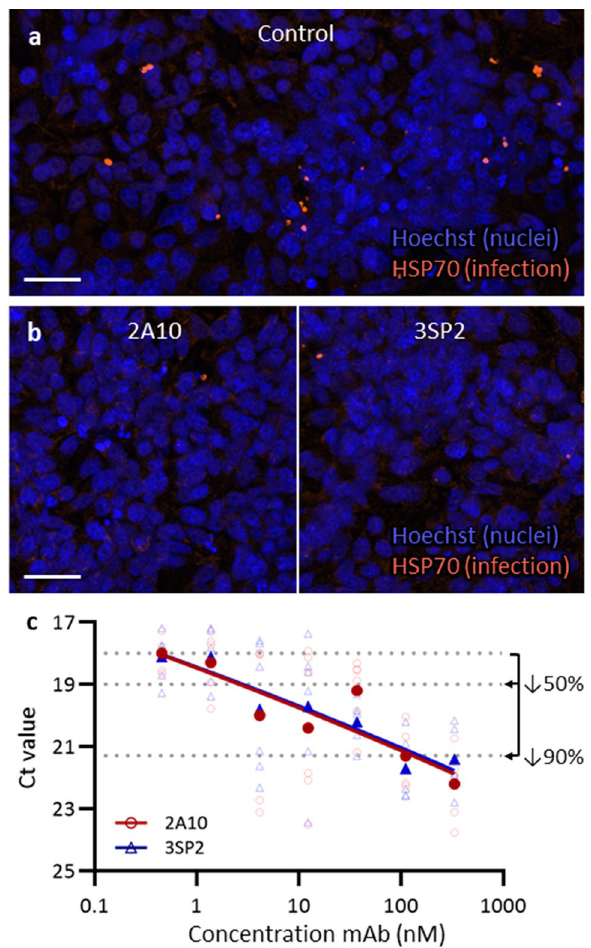
Figure 5. Effect of anti-CSP mAb on HC-04.J7 infection rate ( a ) Immunofluorescent staining of schizonts in HC-04.J7 cells by anti-Hsp70 staining (orange) and counterstaining with Hoechst (blue). Scale bar: 30 µm. ( b ) Images of the liver stage development assay representative for exposure to 333 nM 2A10 and 3SP2. Fluorescent anti-Hsp70 staining (orange) and counterstaining with Hoechst (blue). Scale bar: 30 µm. ( c ) The Ct (cycle threshold) value of 6 wells (open symbols) and the median (closed symbols) obtained by RT-PCR plotted against the concentration of mAb. The Ct values that represent a decrease of 50% and 90% in liver stage development are